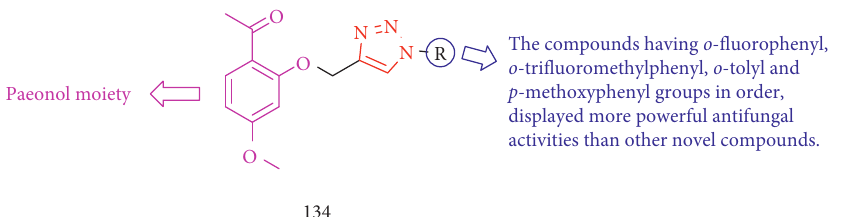
Figure 68: Chemical structure of novel paeonol derivatives linked with 1,2,3-triazole moiety.